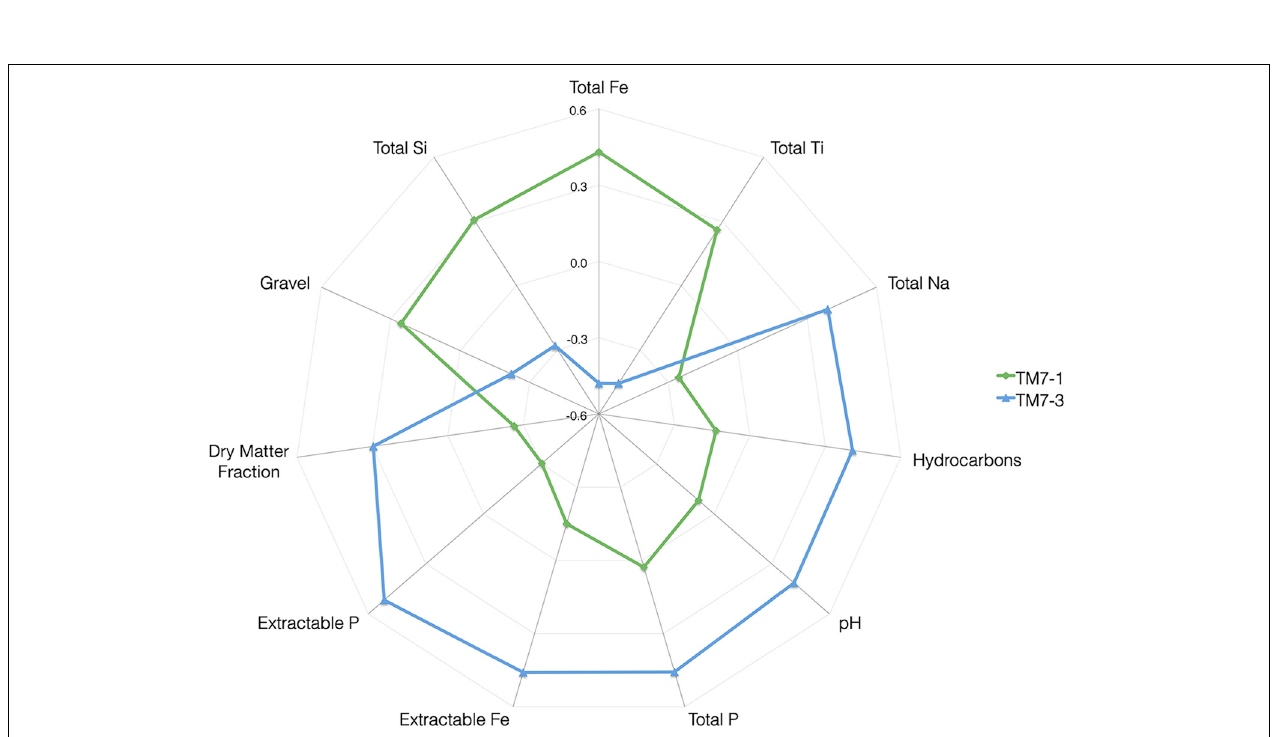
predictor variables and bubbles representing the relative abundance of the different TM7 classes (TM7-1 green, TM7-3 blue). Open diamonds represent Arctic samples and shaded represent Antarctic samples.